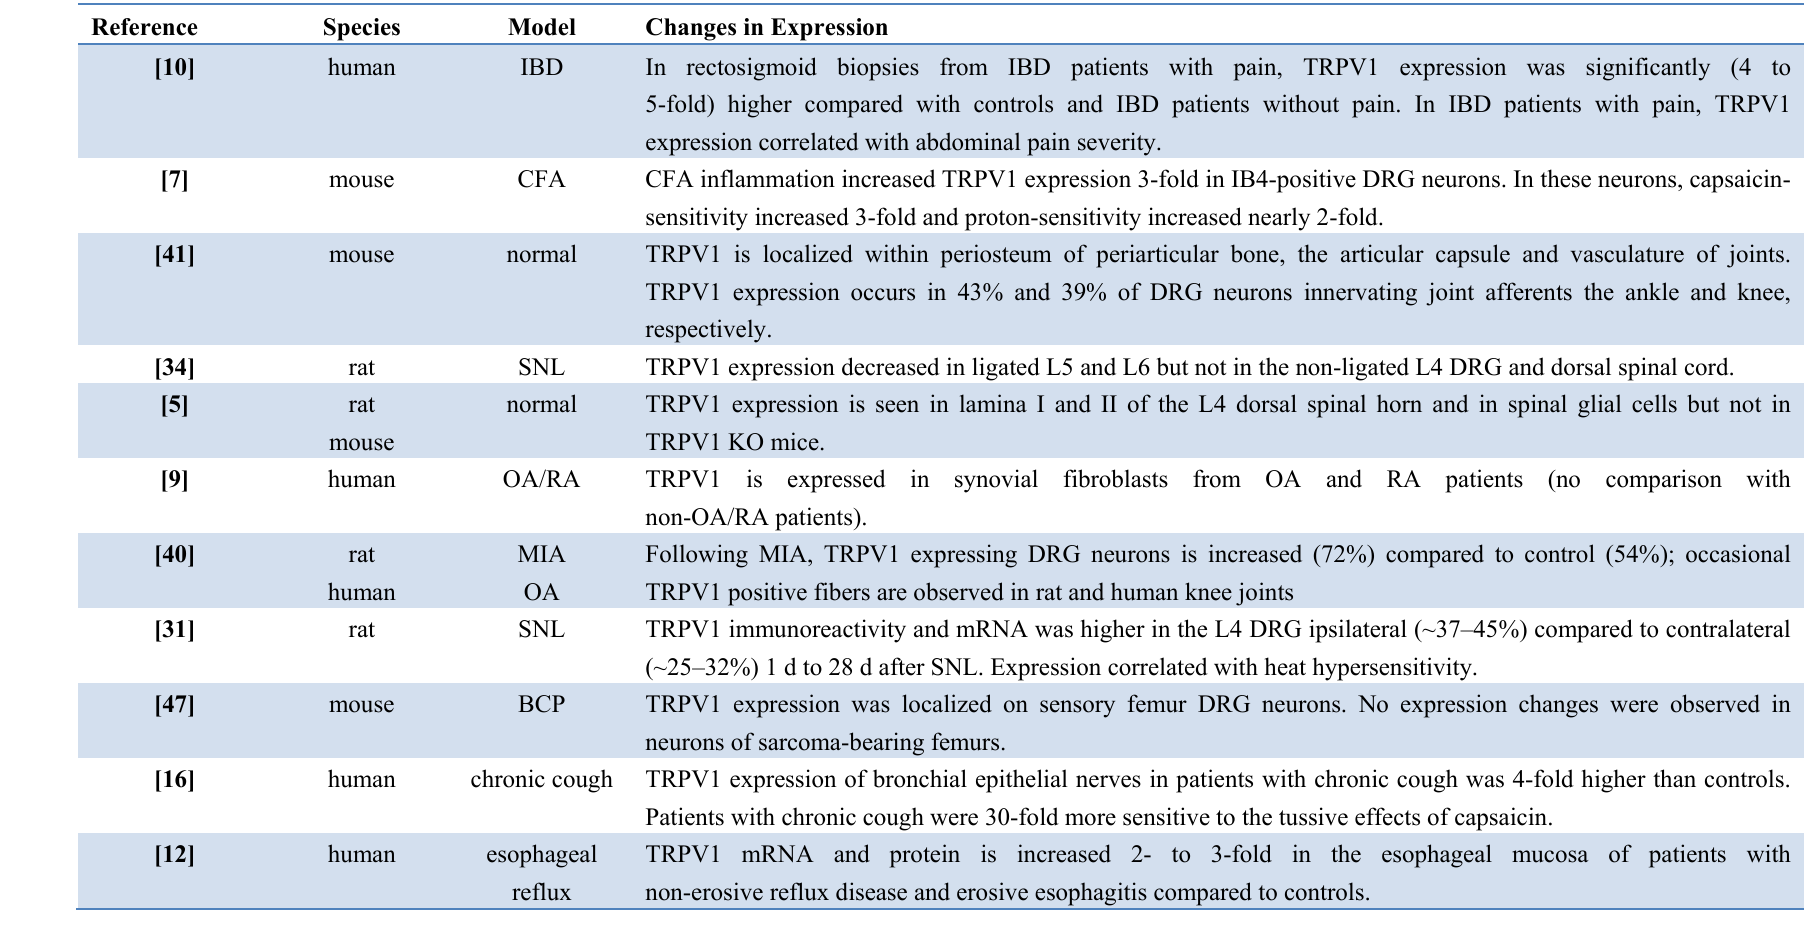
Table 1. Summary of TRPV1 Expression in Pain